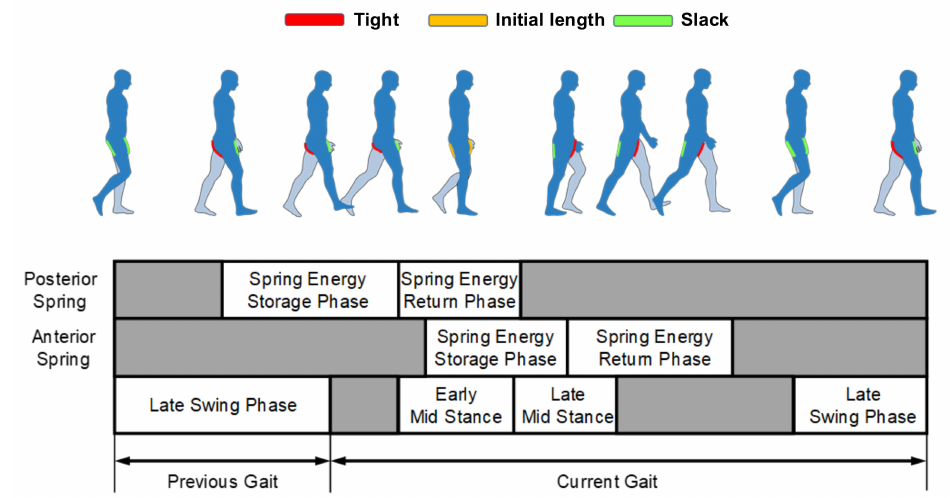
Figure 3. Schematic overview of the functional phases of passive springs located anteriorly and posteriorly across the hip joint in the gait cycle. This begins from the late swing phase in the previous gait to the end of the current gait. Green represents that the spring is slack, yellow represents the initial length of the spring (the spring is pretensioned by 1.5 cm) and red represents that the spring is tight.